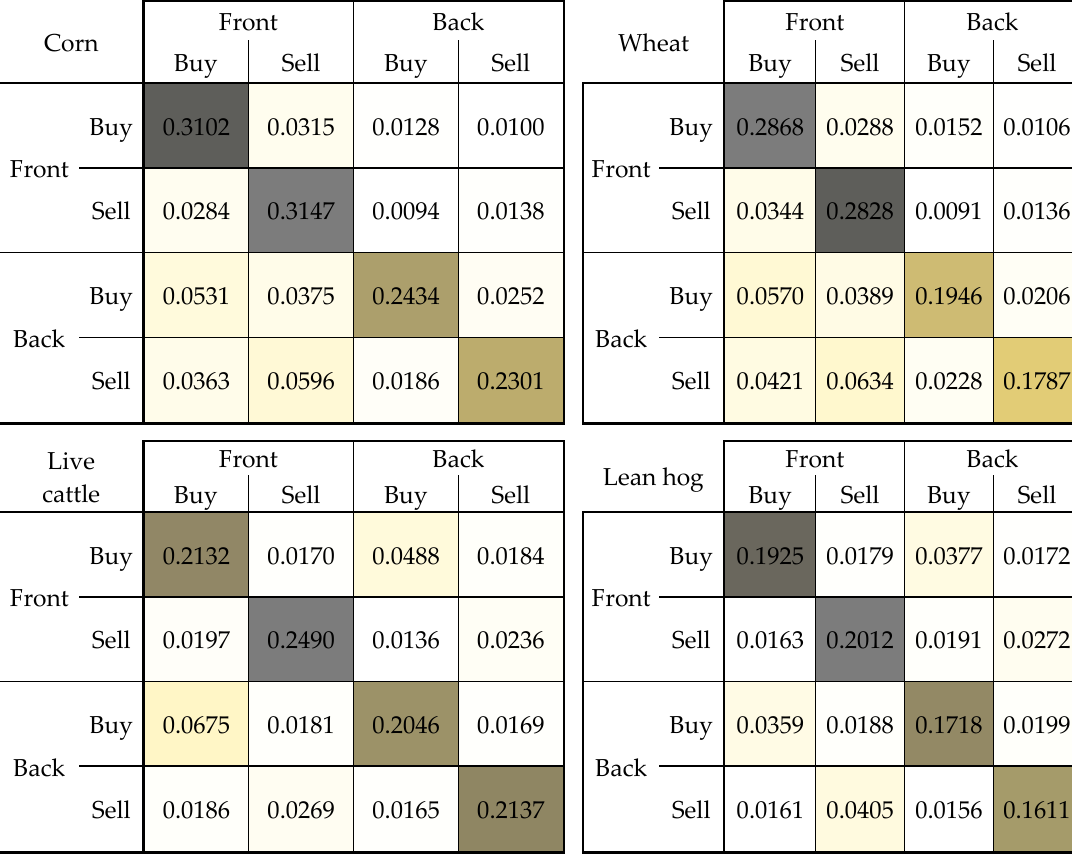
Figure 1. Estimated matrices of kernel norms.